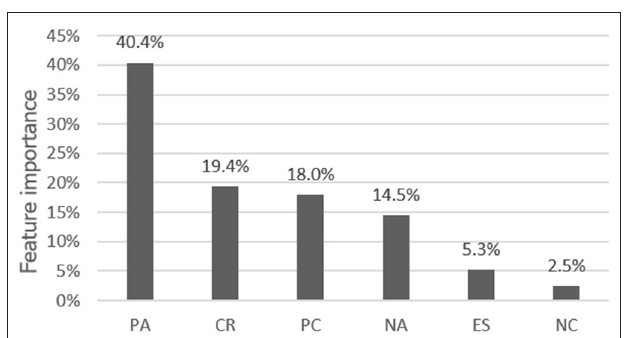
FIGURE 3 | The average feature variable importance to life satisfaction: according to the mean decrease of the Gini Index. PC, positive coping; NC, negative coping; CR, cognitive reappraisal; ES, expression suppression; PA, positive affect; NA, negative